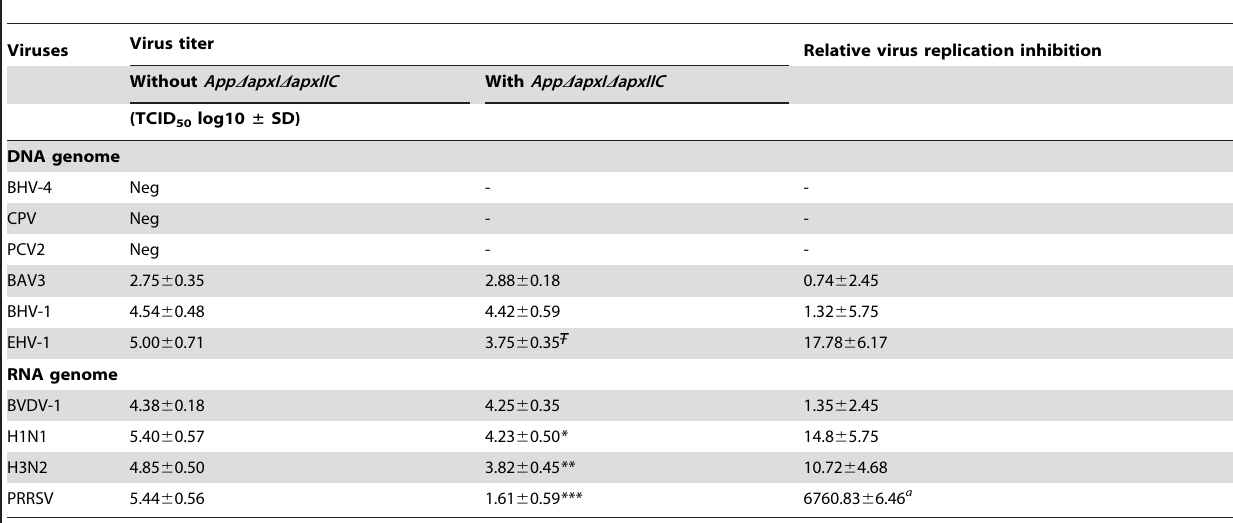
Table 1. Antiviral activity of App D apxI D apxIIC supernatant against several animal DNA and RNA viruses in SJPL infected cells.